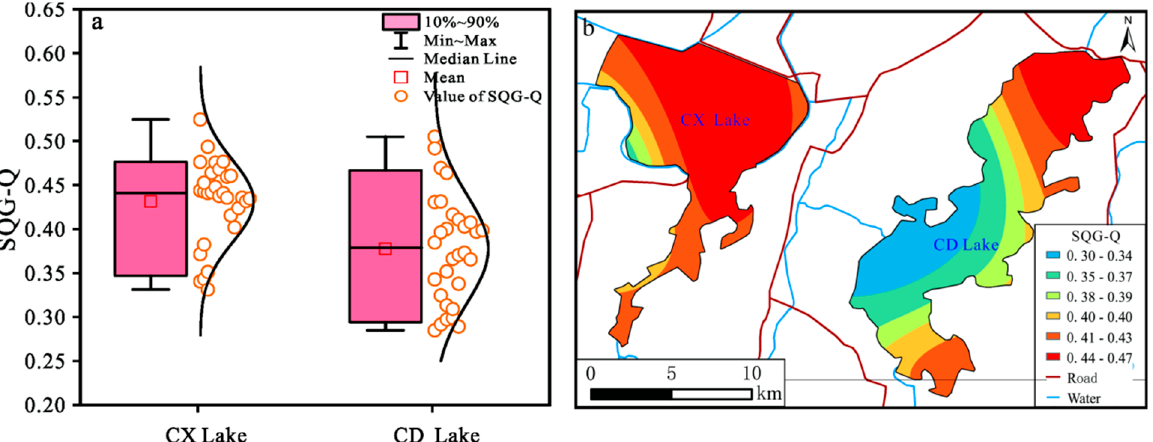
Figure 7. Boxplot ( a ) and spatial distribution ( b ) of SQG − Q of sediment heavy-metal elements.